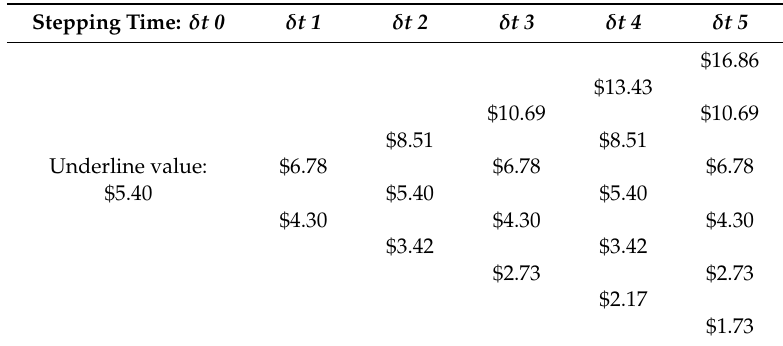
Table 5. The binominal option pricing model: a lattice of the underline values of Natura’s acquisition of The Body Shop (in US$ bn).